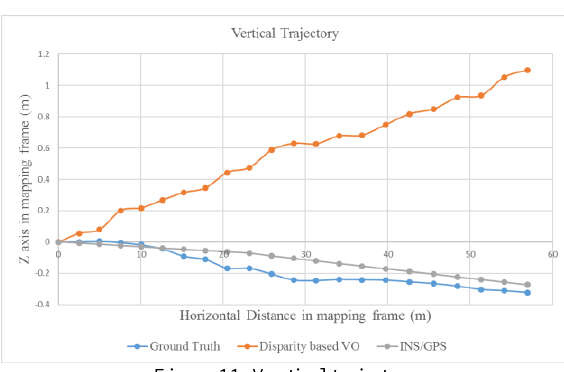
Figure 10. Horizontal trajectory